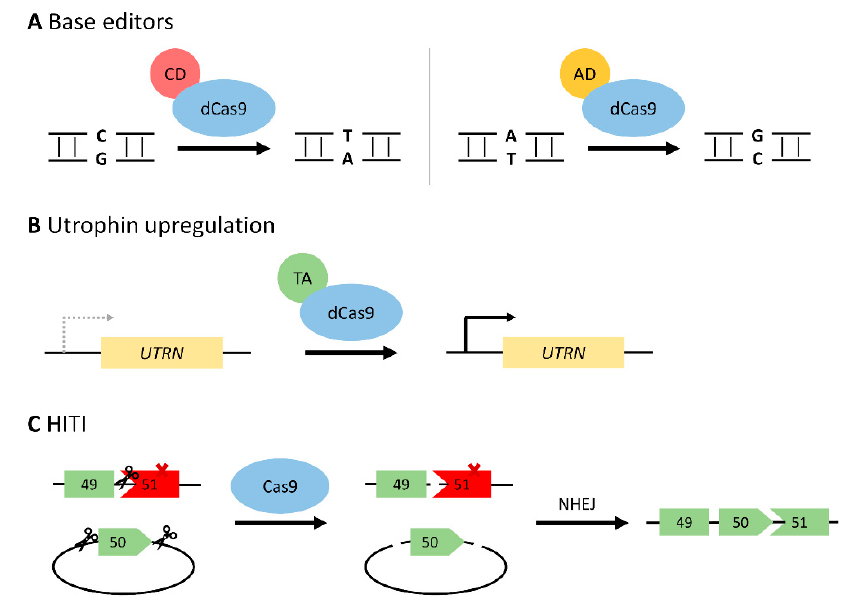
Figure 4. Novel developments to the CRISPR/Cas9 system. ( A ) Precise base editing via dCas9 fused to a cytosine (C:G > T:A) or adenosine (A:T > G:C) deaminase. Base editing could either repair a nonsense mutation, or induce exon skipping by targeting the splice site. ( B ) Transcriptional activator targeted to the utrophin promoter ( UTRN ) in an attempt to compensate for the loss of functional dystrophin. ( C ) Homology-independent targeted integration to knock-in exon 50 in a hypothetical DMD patient lacking exon 50, leading to a frameshift and premature stop codon in exon 51 (denoted by X). A donor plasmid is delivered with the desired exon, flanked by CRISPR/Cas9 cut sites. Cas9 will cleave both the genomic DNA and the donor plasmid, followed by NHEJ. Scissors represent Cas9 cut sites. Abbreviations: dCas9, deactivated Cas9; CD, cytosine deaminase; AD, adenosine deaminase; TA, transcriptional activator; HITI, homology-independent targeted integration; NHEJ, non-homologous end joining.